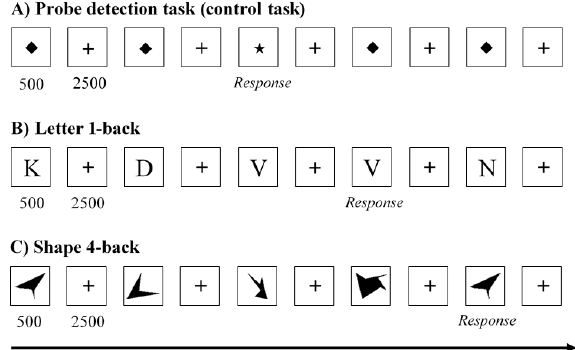
Figure 1. Illustration of the probe detection task (control task) (A), the letter version (B), and shape version (C) of the n-back task.